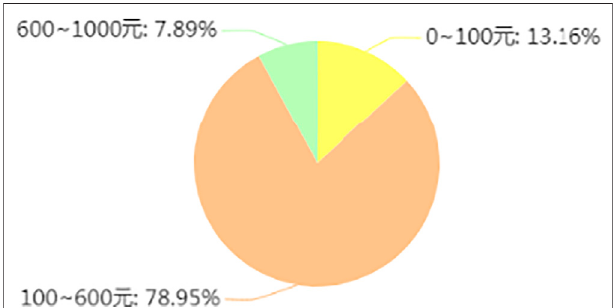
FIGURE 2 | Amount of peasant households ’ willingness to be